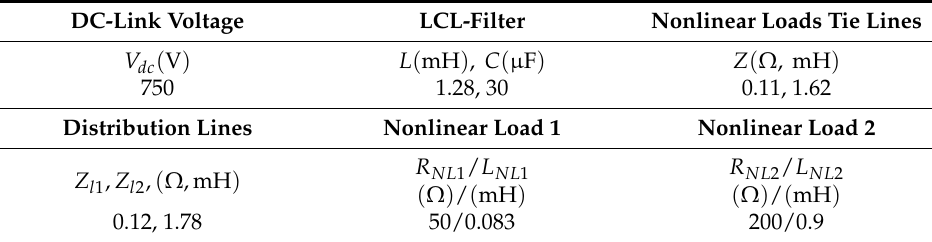
Table 1. Power stage